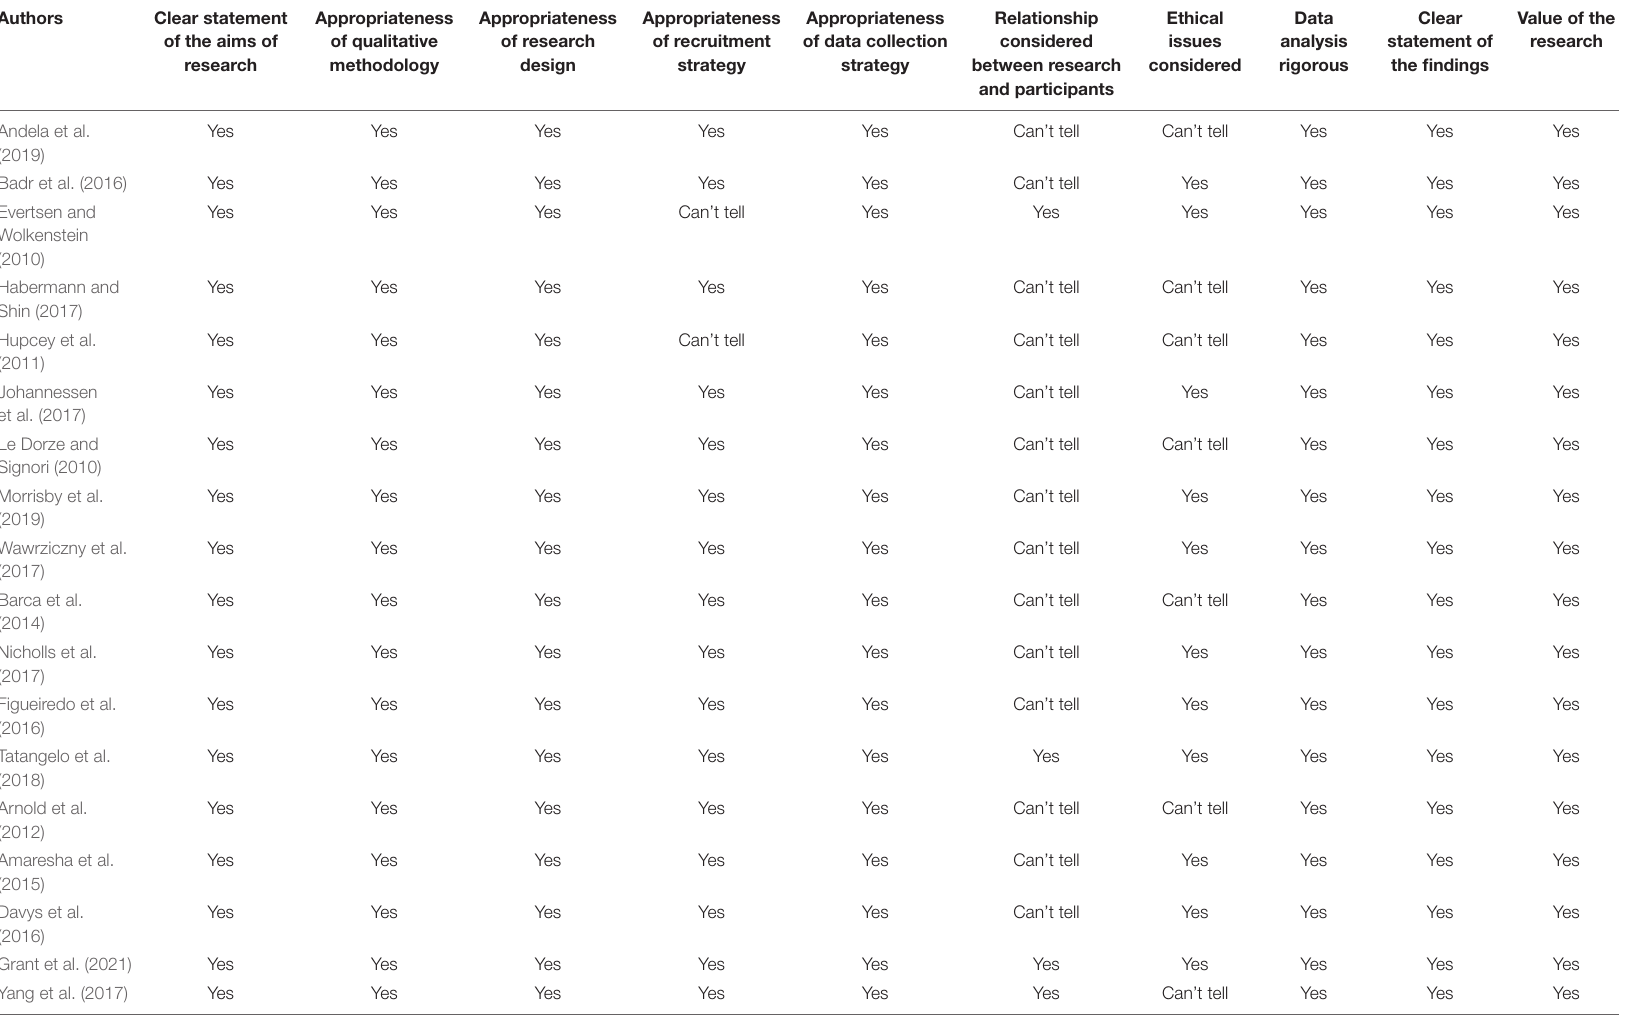
TABLE 1 | Quality assessment of qualitative studies according to the Critical Appraisal Skills Program